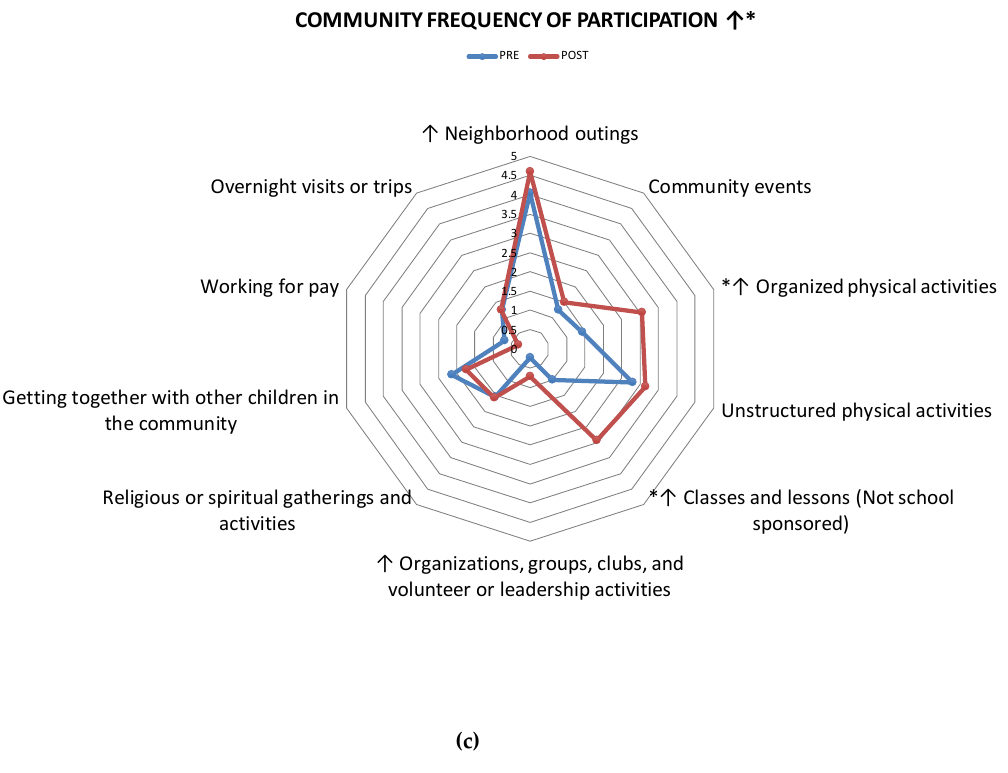
Figure 1. Frequency of participation in the home ( a ), school ( b ), and community settings ( c ) (n = 20). 0 = Never, 1 = Once in the last four months, 2 = Few times in the last four months, 3 = Once a month, 4 = Few times a month, 5 = Once a week, 6 = Few times a week, 7 = Daily. ↑ / ↓ = Mean increase / decrease of at least 0.5. * p < 0.05